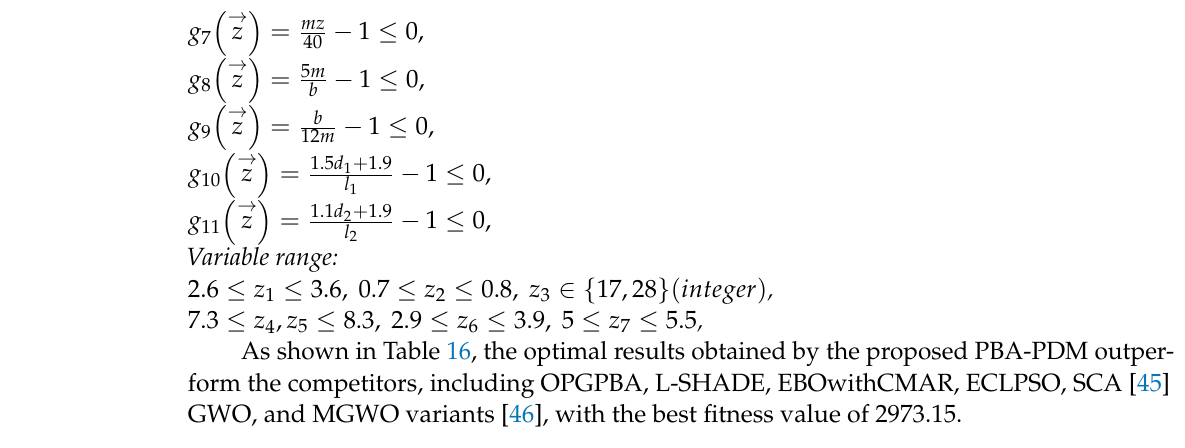
Table 16. The comparison of PBA-PDM with other optimizers in Speed Reducer Design.